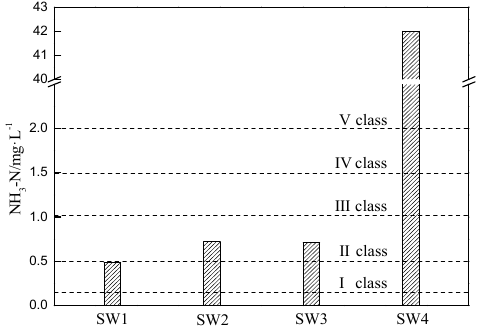
Figure 1. Classification of aqueous ammonium in small basin (sample water, SW1–SW4) according to the Chinese environmental quality standards for surface water (GB3838-2002).